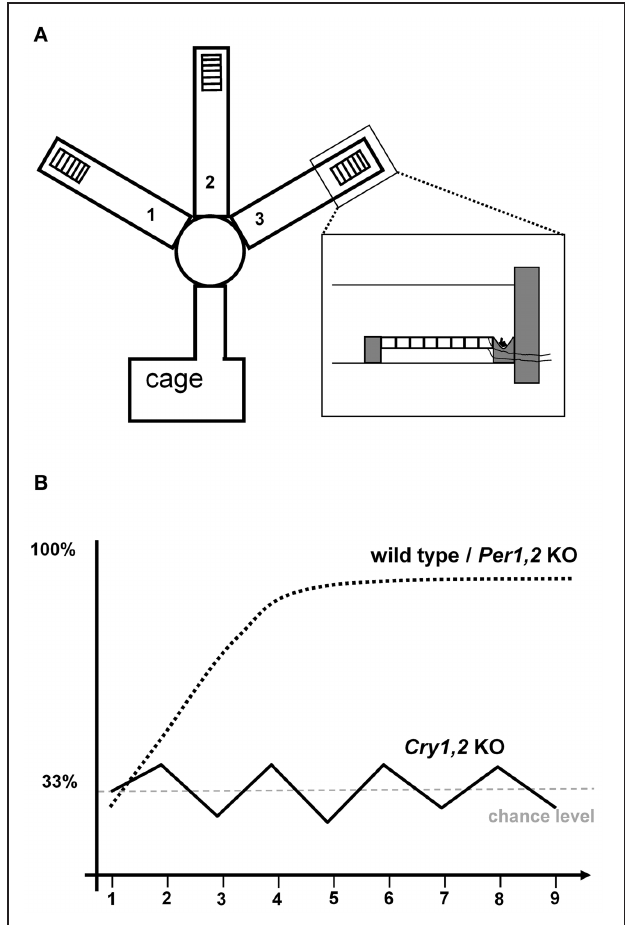
FIGURE 1 | Schematic drawing of the TPL maze used by Van der Zee et al. (2008). Food is placed behind a metal grid on which mice have to stand to reach it, providing the possibility to administer a mild foot shock (A) . Schematic representations of the learning curve: wild-type and Per1,2 mutant mice readily learn to avoid the “time-of-day dependent” negatively reinforced location. In contrast, Cry1,2 knockout mice cannot master the task and remain at the 33% chance level (B)